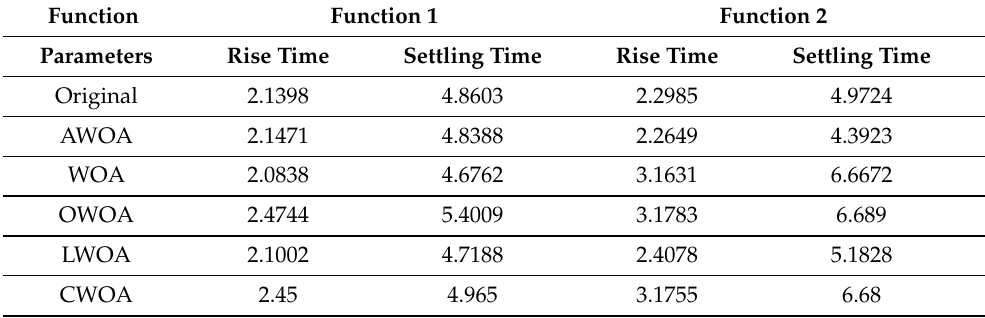
Table 10. Simulated models for different WOA variants and time domain specifications.